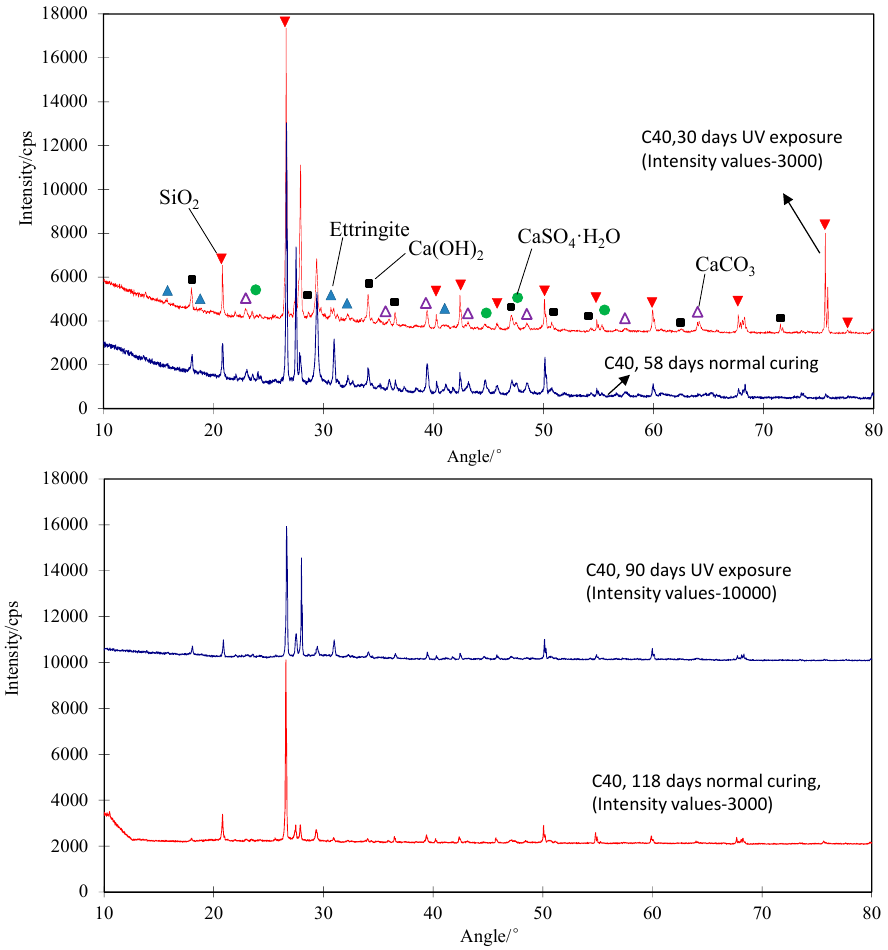
Figure 16. X-ray diffraction analysis of concrete (40 MPa) before and after UV exposure.